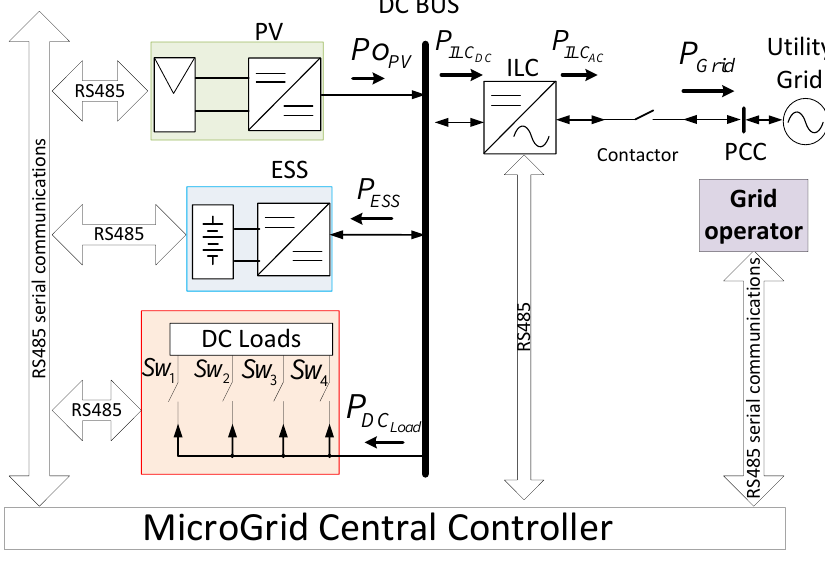
Figure 1. Conceptual scheme of the DC microgrid.